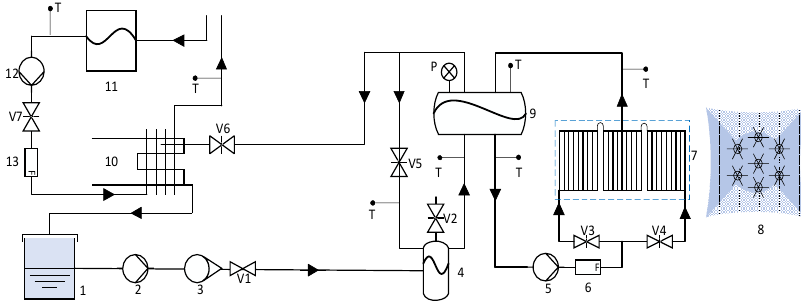
Figure 1. System sketch of the experimental platform.